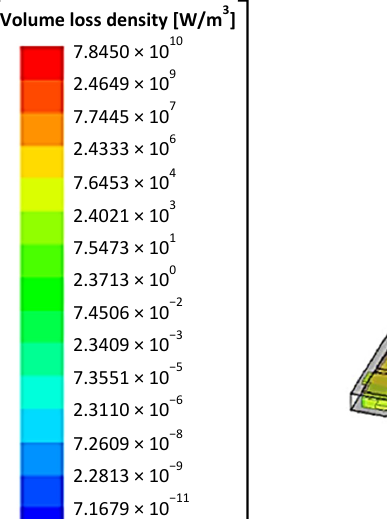
Figure 6. Surface current density, with a current equal to 90 A at 500 kHz as input.